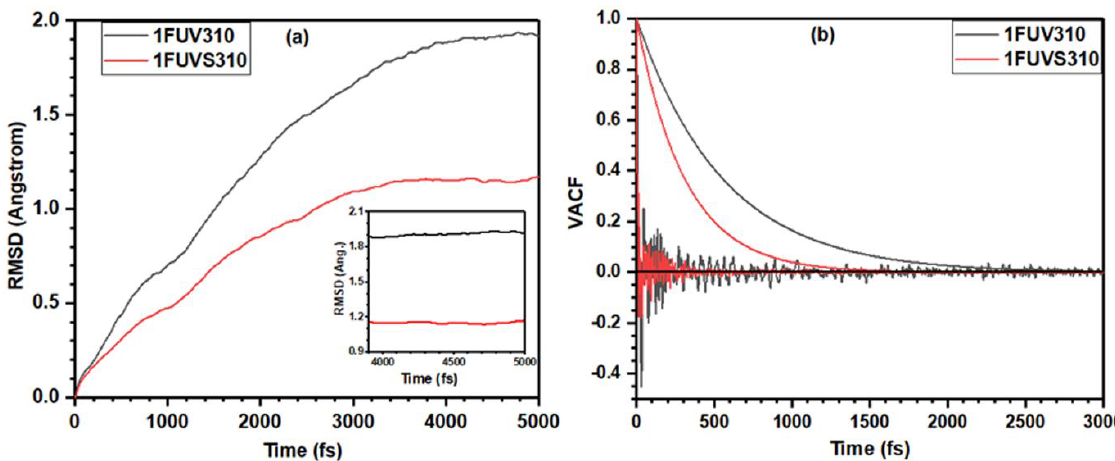
Figure 1. Calculated ( a ) RMSD and ( b ) VACF including exponential fitting, of simulated dry and solvated 1FUV peptide at 310 K.